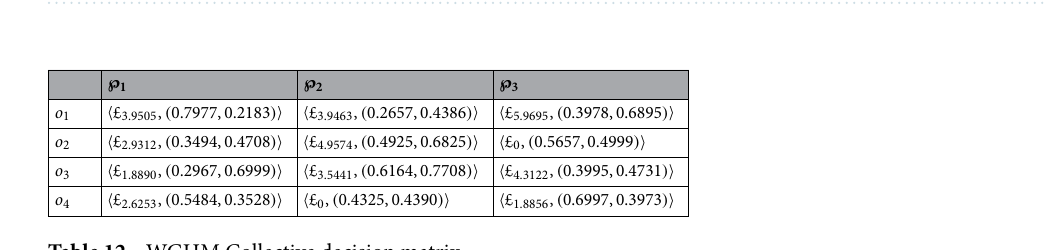
Table 12. WGHM Collective decision